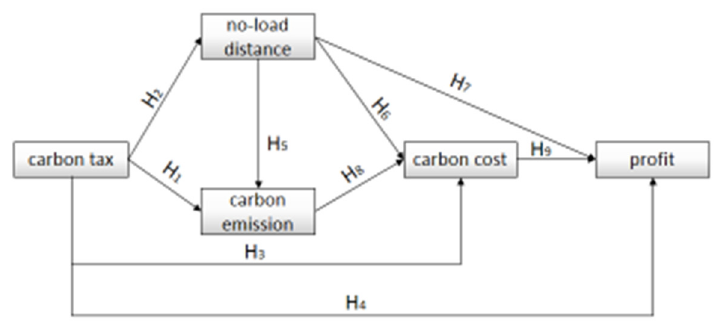
Figure 2. Relationship diagram between elements.